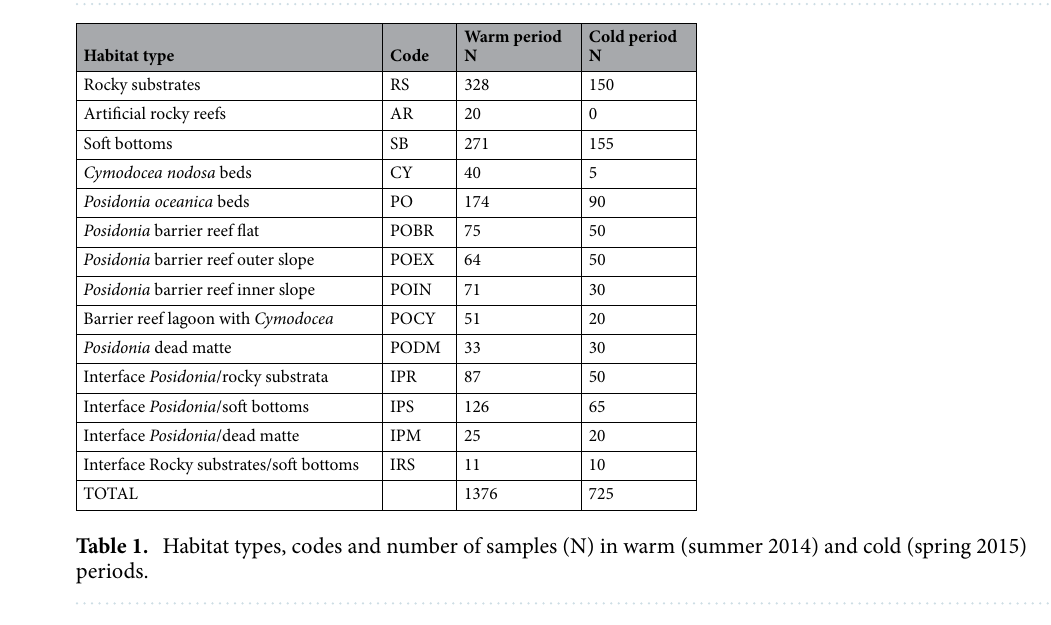
Figure 1. Map of the studied area: 42 stations were sampled along the 100 km stretch of the studied portion of the French Provence coastline (black rectangle). The map was drawn using free and open source software Inkscape 0.91 (https:// inksc ape. org/ en/) and QGIS 2.14 (http:// www. qgis. org/). Map was drawn by authors using online Standard tile layer from OpenStreetMap data as background model (© OpenStreetMap contributors), available under ODbL licence (CC-BY-SA) at http:// www. opens treet map. org/.